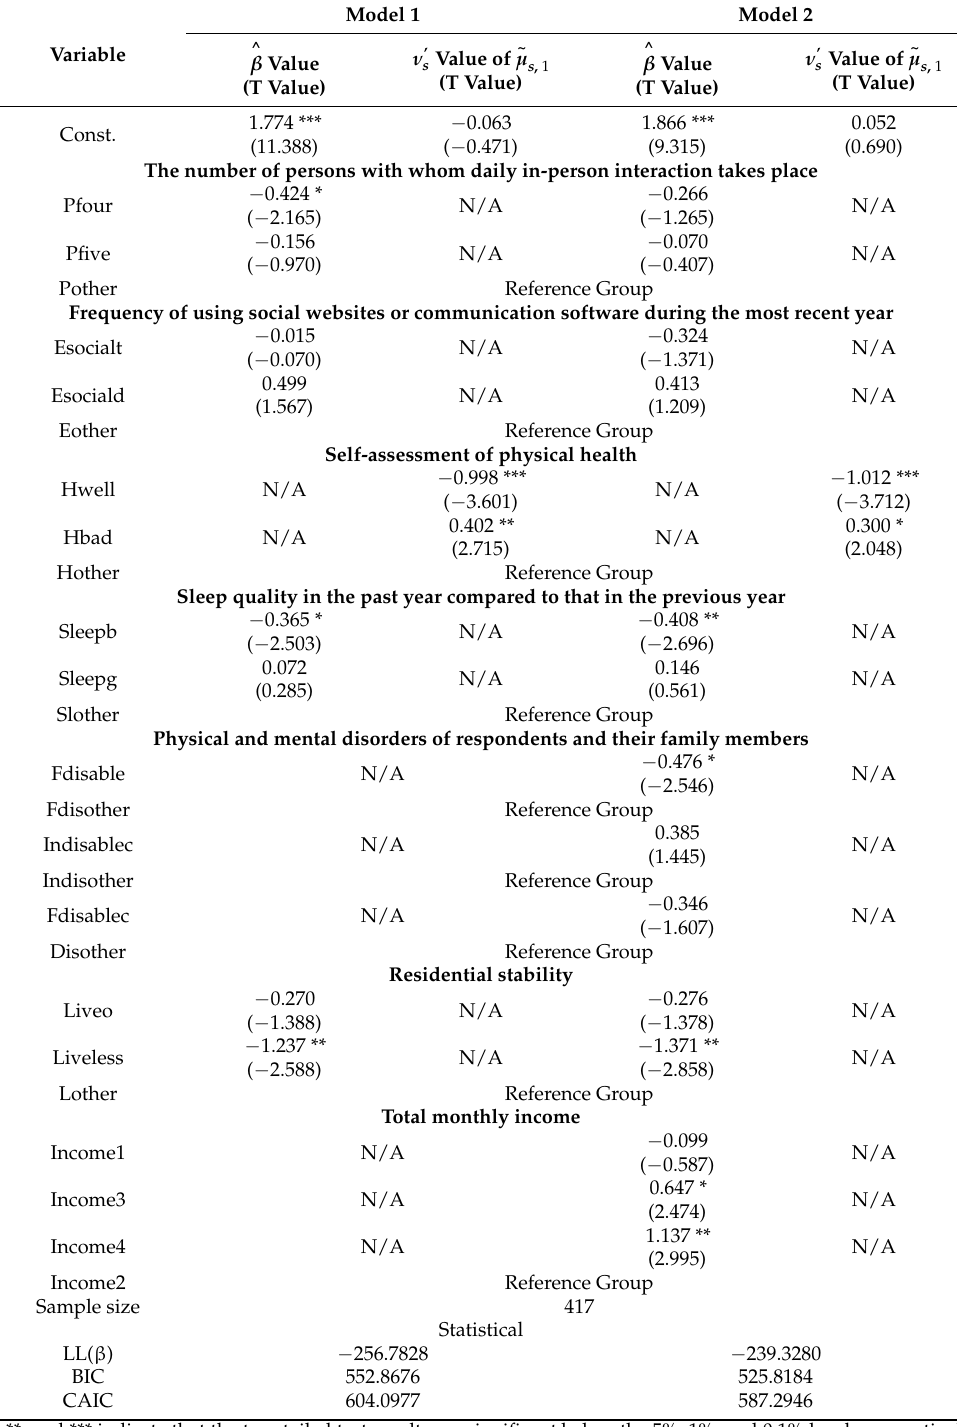
Table 2. The results of executing the GOP